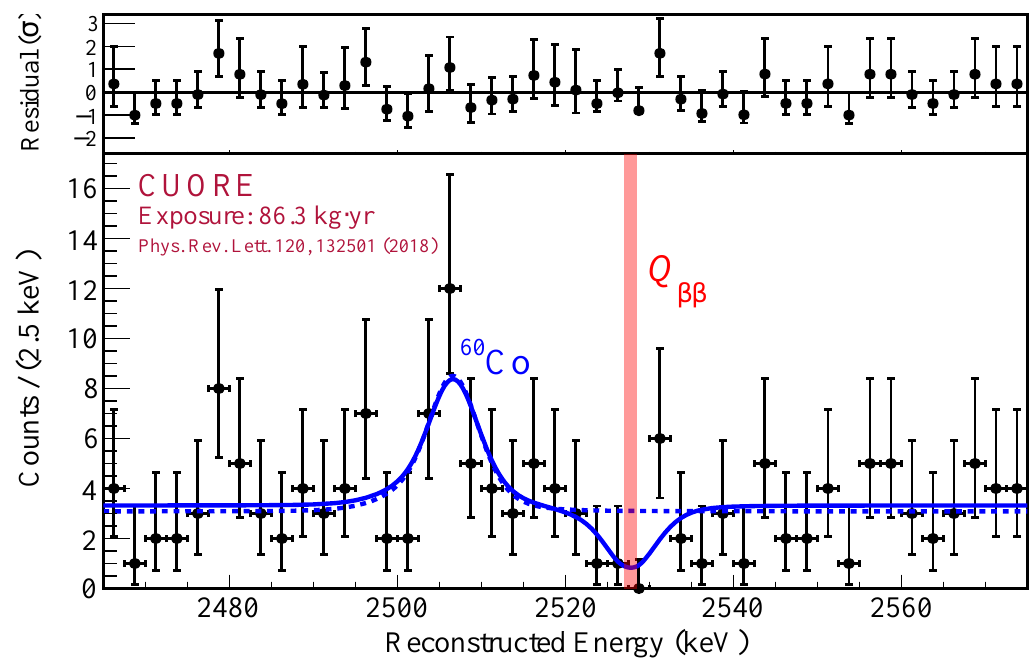
Figure 2. Left : reconstructed 208 Tl 2516 keV line in the calibration spectrum with residuals with data points (black) and the reconstructed line-shape (red). The dotted blue lines are the components of the line shape corresponding to different physical processes. Right : the best fit in the ROI. The value of the Q ββ is marked in red. Picture taken from